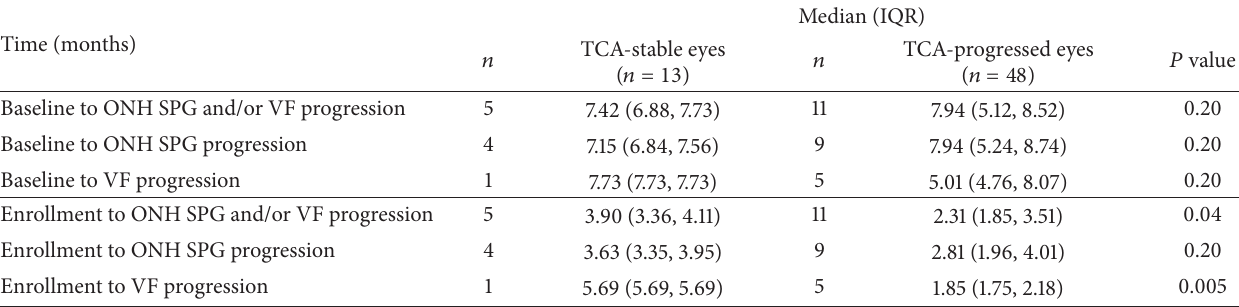
Table 4: Median times to clinical (ONH stereophotograph and/or Visual Field) progression for TCA-stable and TCA-progressed eyes throughout the whole